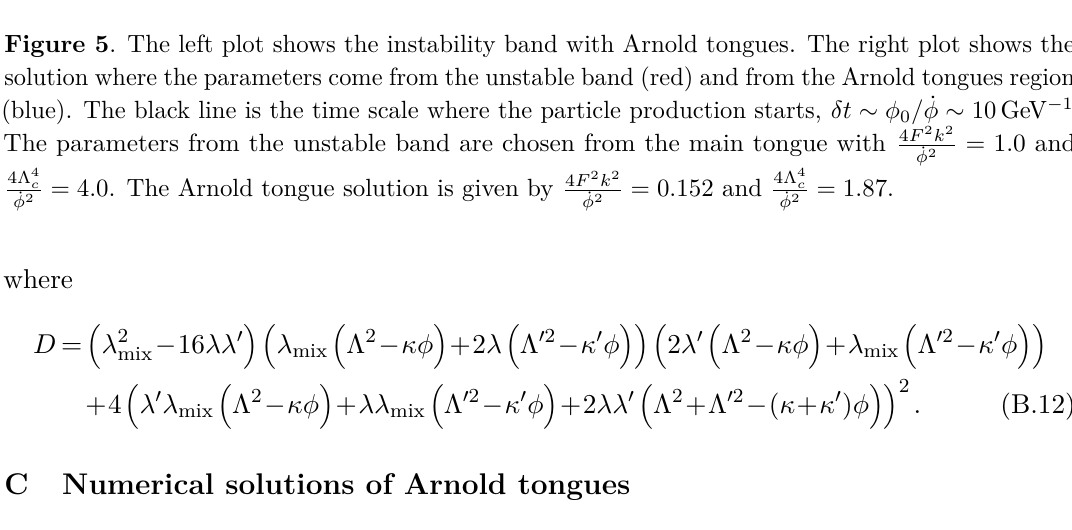
= 1 . 0 and ˙ φ 2 4 = 0 . 152 and 4Λ = 1 . 87 c ˙ φ 2 ˙ φ 2